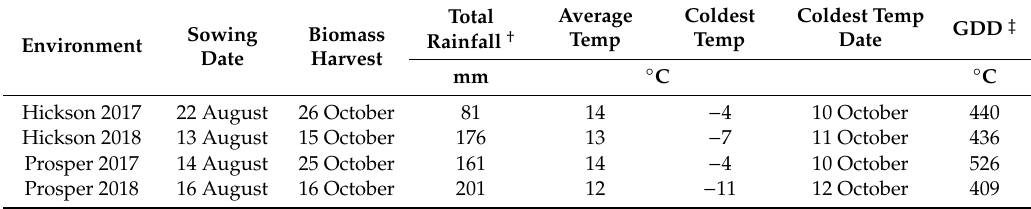
Table 1. Sowing and harvest of cover crops and weather data for each location and year (environment).